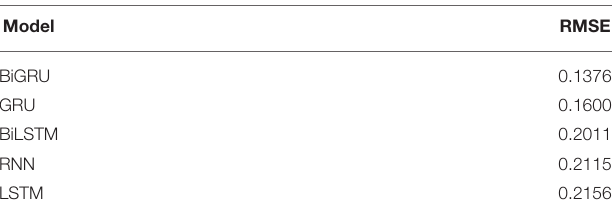
TABLE 3 | Time series prediction.